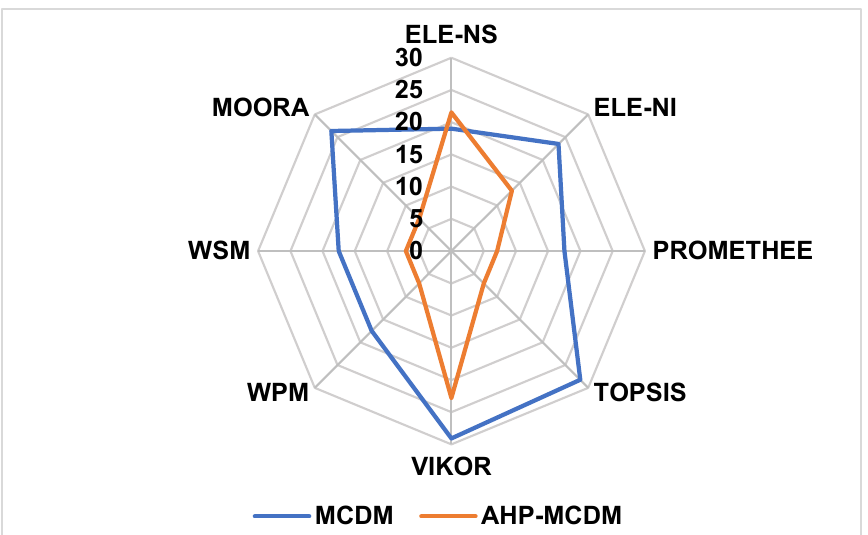
Figure 4. Graph of calculated error in pairs.